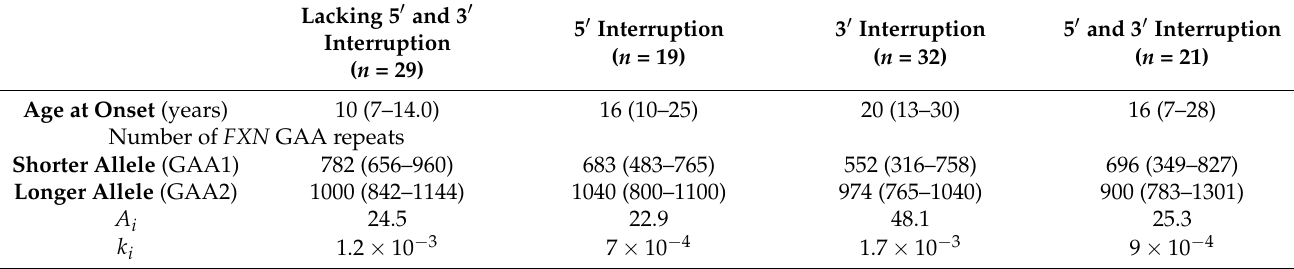
Table 1. Summary statistics of the cohort used in this study. Data are median (interquartile range). The modelling coefficient ( A i ) and rate constant ( k i ) for each subgroup are also